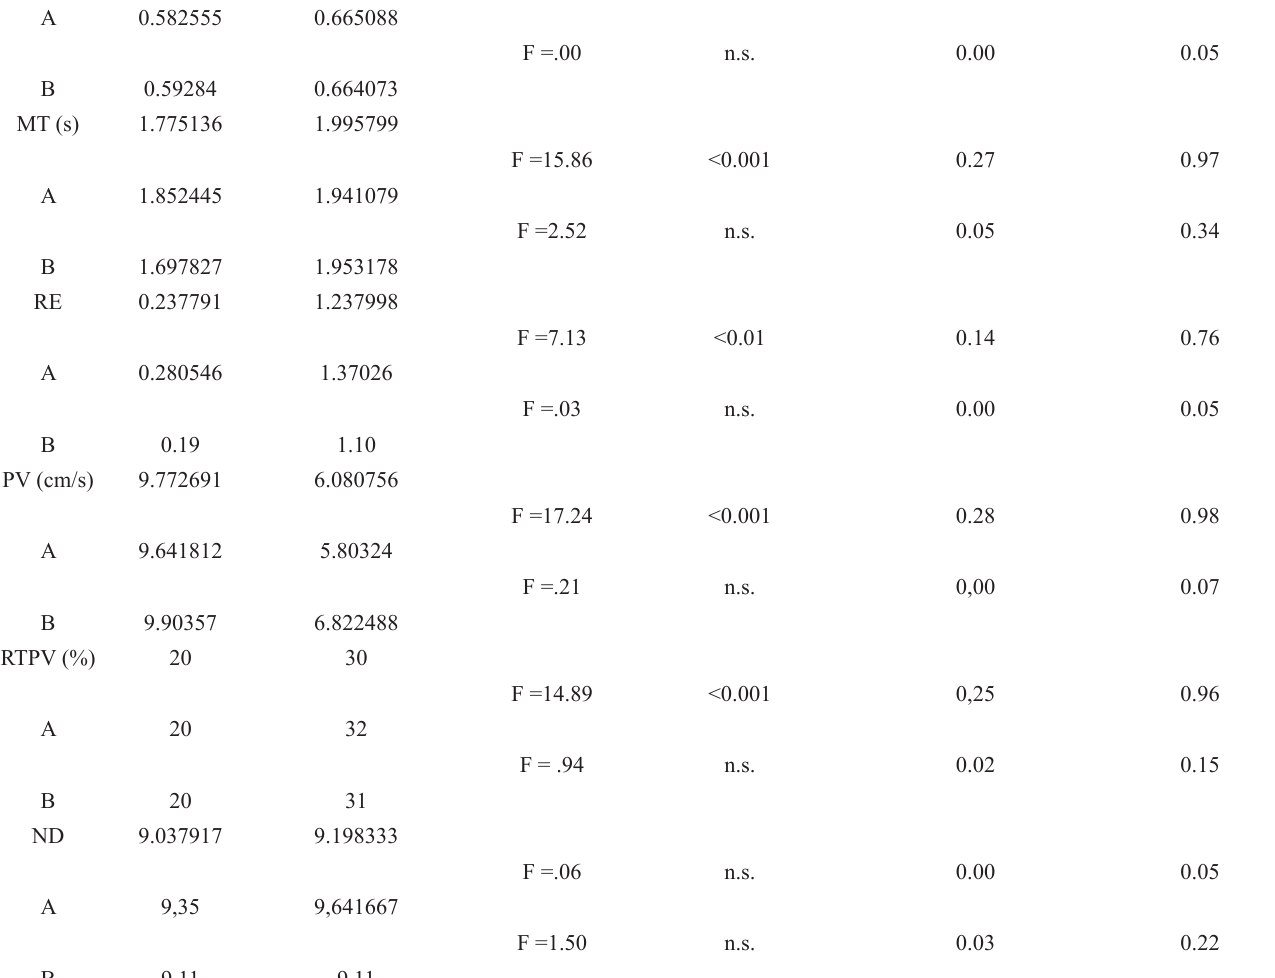
Figueiredo L. S. & Apolinário-Souza T. & Lelis-Torres N. & Lage G. M. & Ugrinowitsch